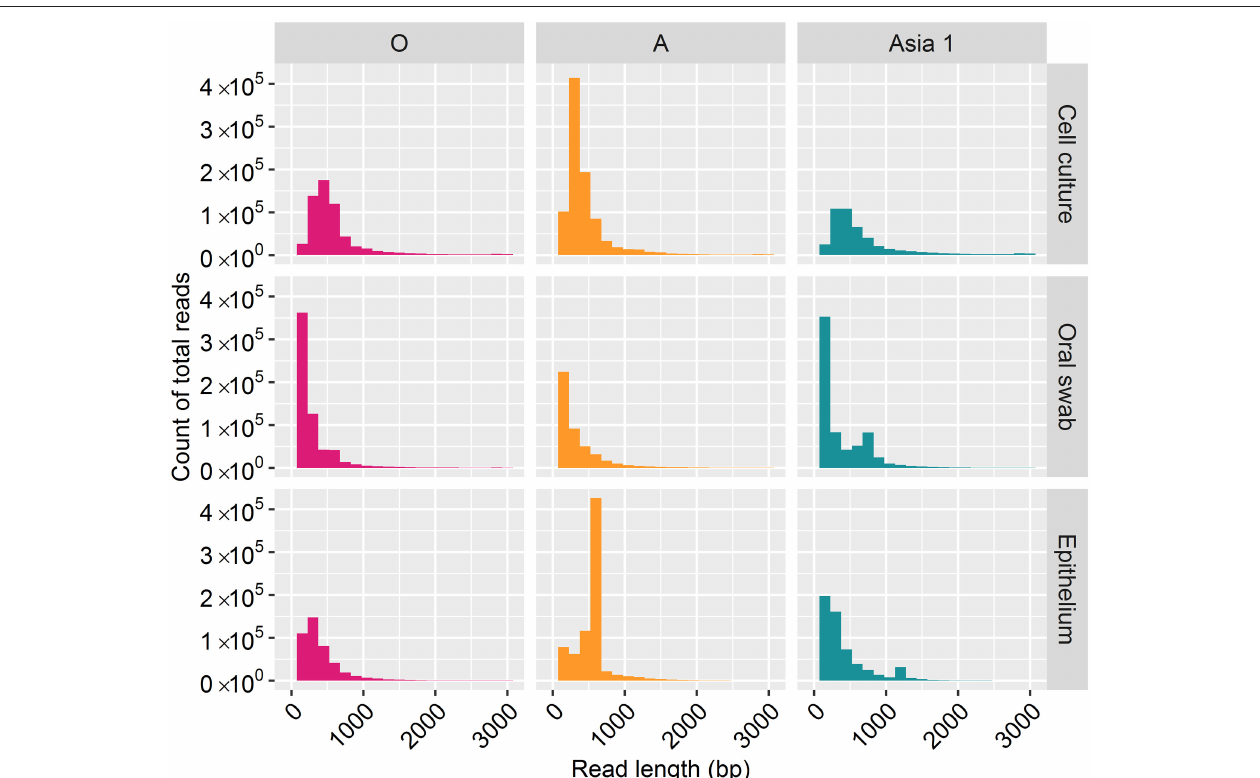
FIGURE 1 | Frequency distribution of MinION read lengths from each sample generated after 30h of nanopore sequencing.